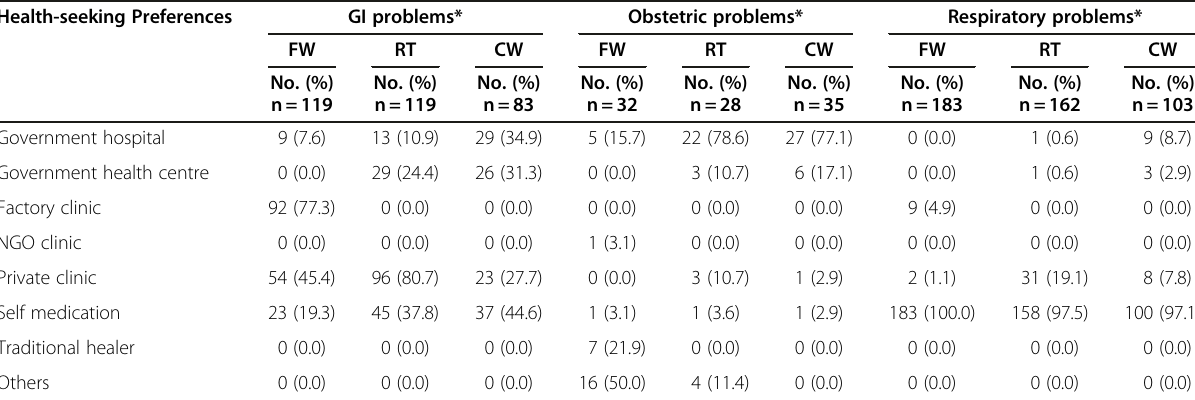
Table 3 Healthcare-seeking preferences among migrant workers for GI, obstetric and respiratory problems by occupation Health-seeking Preferences